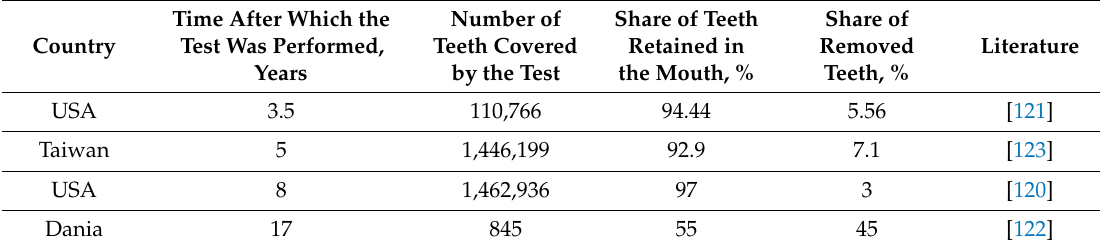
Table 4. Selected epidemiological data regarding the time of endodontic treatment of teeth in the oral cavity.